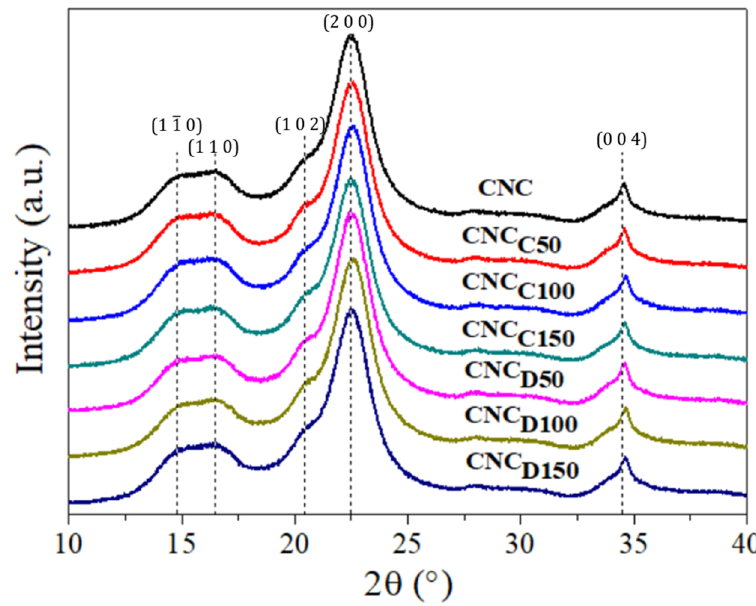
Figure 4. XRD diffractograms of CNCs and m -CNCs.